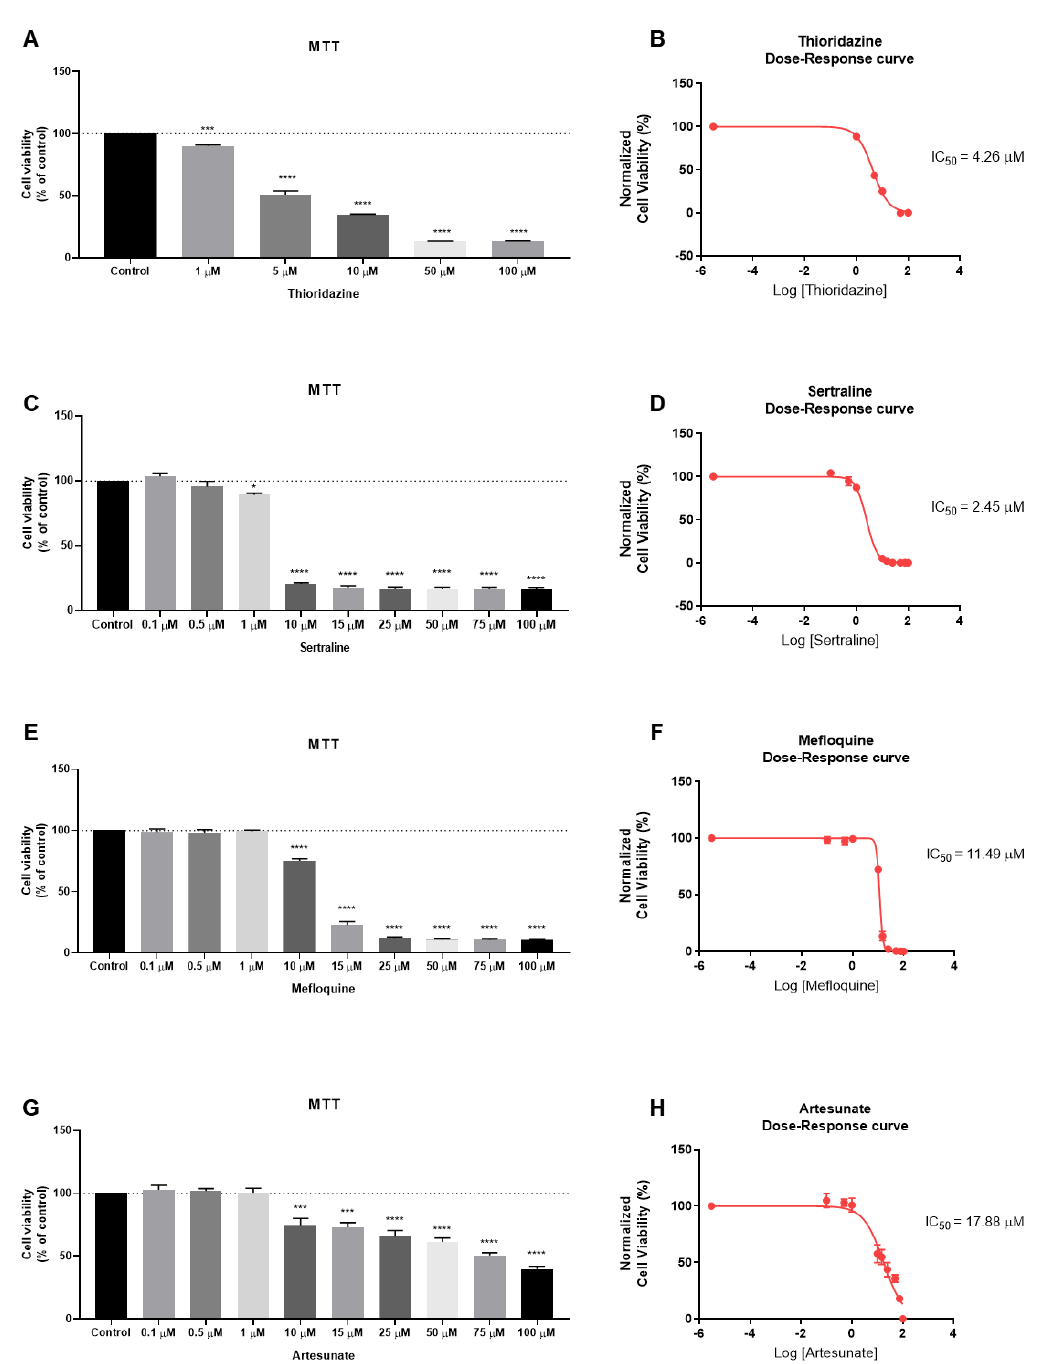
Figure 3. The effects of some CNS drugs and antimalarial drugs on HT-29 cells. ( A ) The effect of thioridazine on cell viability and ( B ) the dose-response curve. ( C ) The effect of sertraline on cell viability and ( D ) the dose-response curve. ( E ) The effect of mefloquine on cell viability and ( F ) the dose-response curve. ( G ) The effect of artesunate on cell viability and ( H ) the dose-response curve. Cells were cultured in the presence of increasing concentrations of each drug, and after 48 h, the MTT assay was performed to measure the cellular viability. Values are expressed in percentage of control and represent means ± SEM. Each experiment was done three times independently ( n = 3); * statistically significant vs. control at p < 0.05. *** statistically significant vs. control at p < 0.001. **** statistically significant vs. control at p <